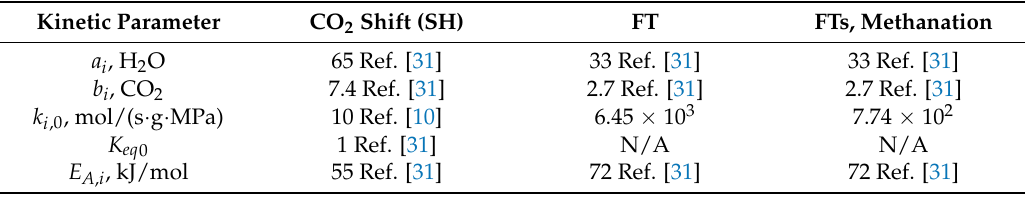
Figure 4. Reactor geometry with model-predicted contours of C 3 H 6 concentration, mol/m 3 , formed by carbon dioxide hydrogenation in the catalyst bed (20Cu80Fe/K) with bed porosity of 0.51 and particle porosity of 0.38 at 300 °C and 20 bar total pressure at the reactor outlet. Table 5. Kinetic parameters used for the modeling of 80Fe20Cu/K.